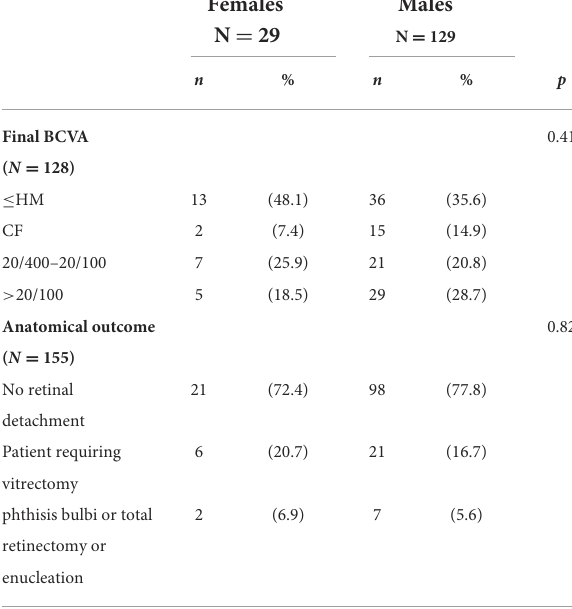
TABLE 4 Comparative analysis of outcomes between males and females.